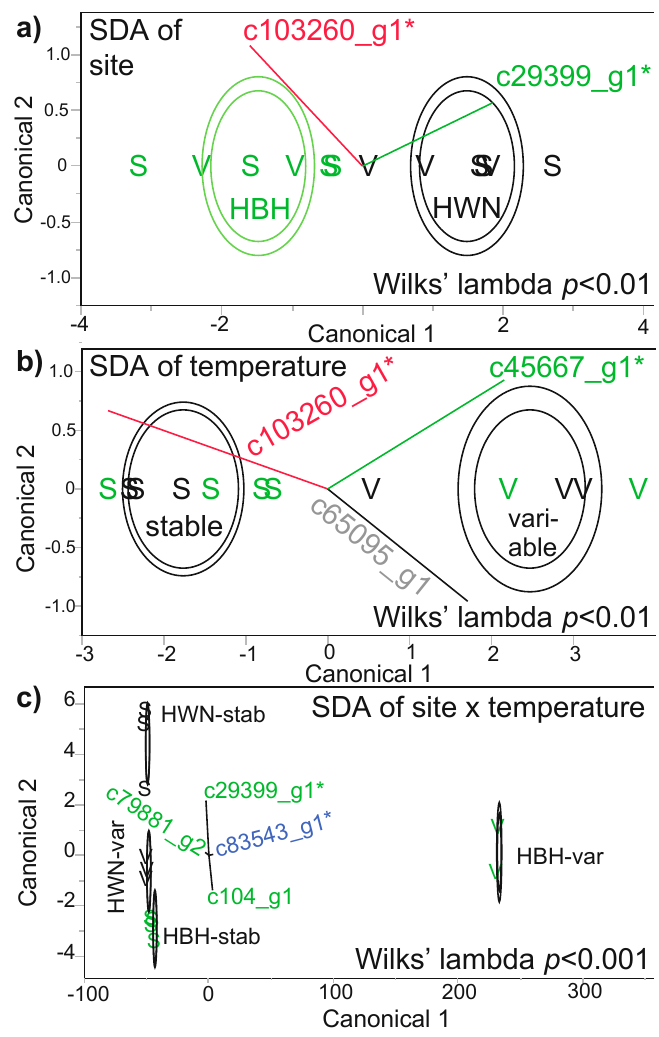
Figure 4. Stepwise discriminant analysis (SDA). The results of SDA using all 30 proteins as predictors for site of origin ( a ), temperature treatment ( b ), and their interaction ( c ). In all cases, the model built from the incorporated proteins (grey, green, blue, and red biplot rays for coral host, Symbiodiniaceae, bacterial, and proteins of unknown origin, respectively) correctly predicted the identity of all 12 samples (0% misclassification rate). Putative differentially concentrated proteins (DCPs) identified by response screening analysis (Figure 3) have been denoted by asterisks, and inner and outer contours represent 50 and 95% confidence, respectively. In certain cases, the stable (stab; S) and variable (var; V) temperature icons overlap, and Houbihu (HBH) and Houwan (HWN) icons are highlighted in green and black font, respectively. In panel c , some of the icons are masked by the contours, and the horizontal vectors (i.e., c79881_g2 and c83543_g1) are relatively compressed. Please also note that the significant MANOVA interaction effect in panel c should be interpreted cautiously given the low sample size of the HBH-var interaction group ( n =2).